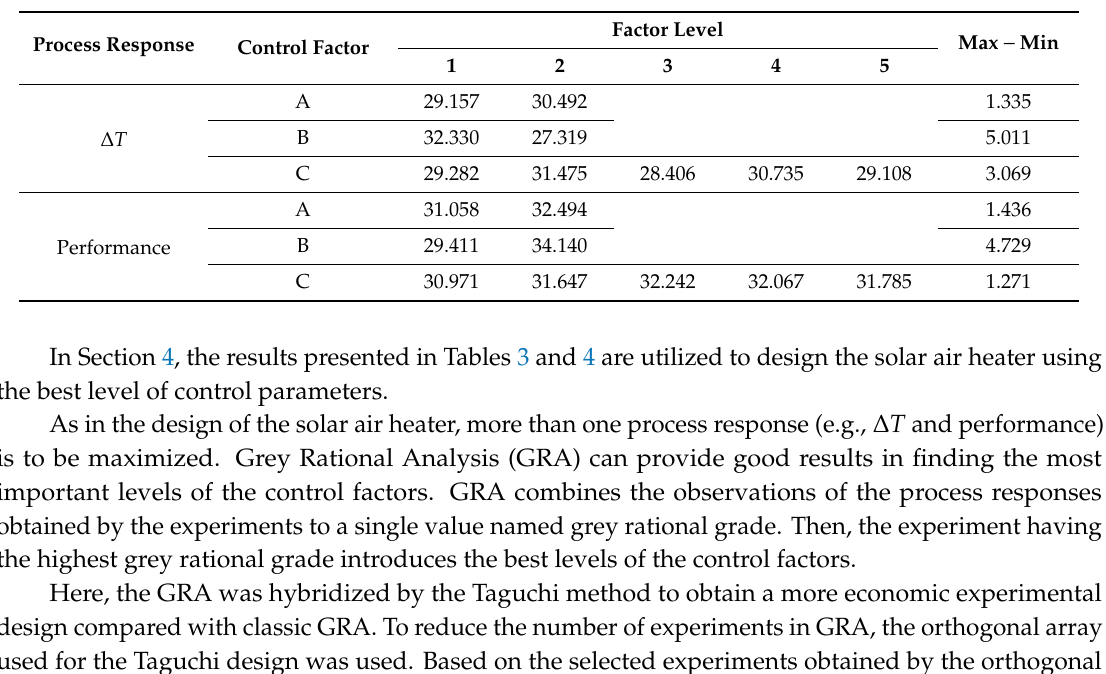
Table 4. Average of the S / N ratios of each level of the control factors for each process